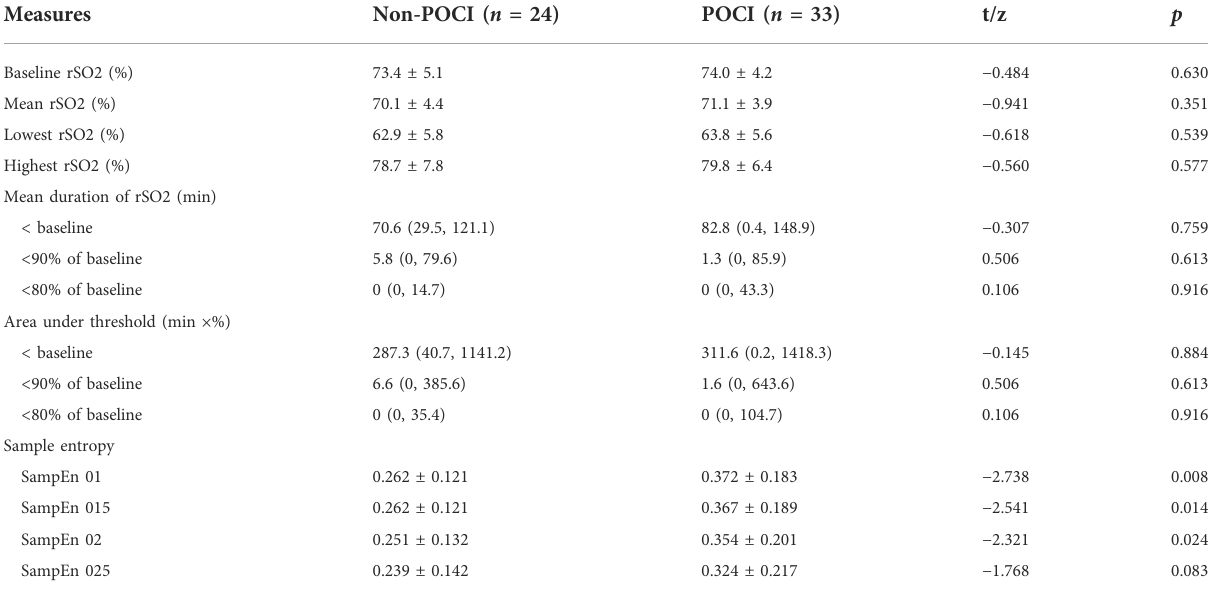
TABLE 2 Intraoperative cerebral tissue oxygenation in patients with and without POCI.